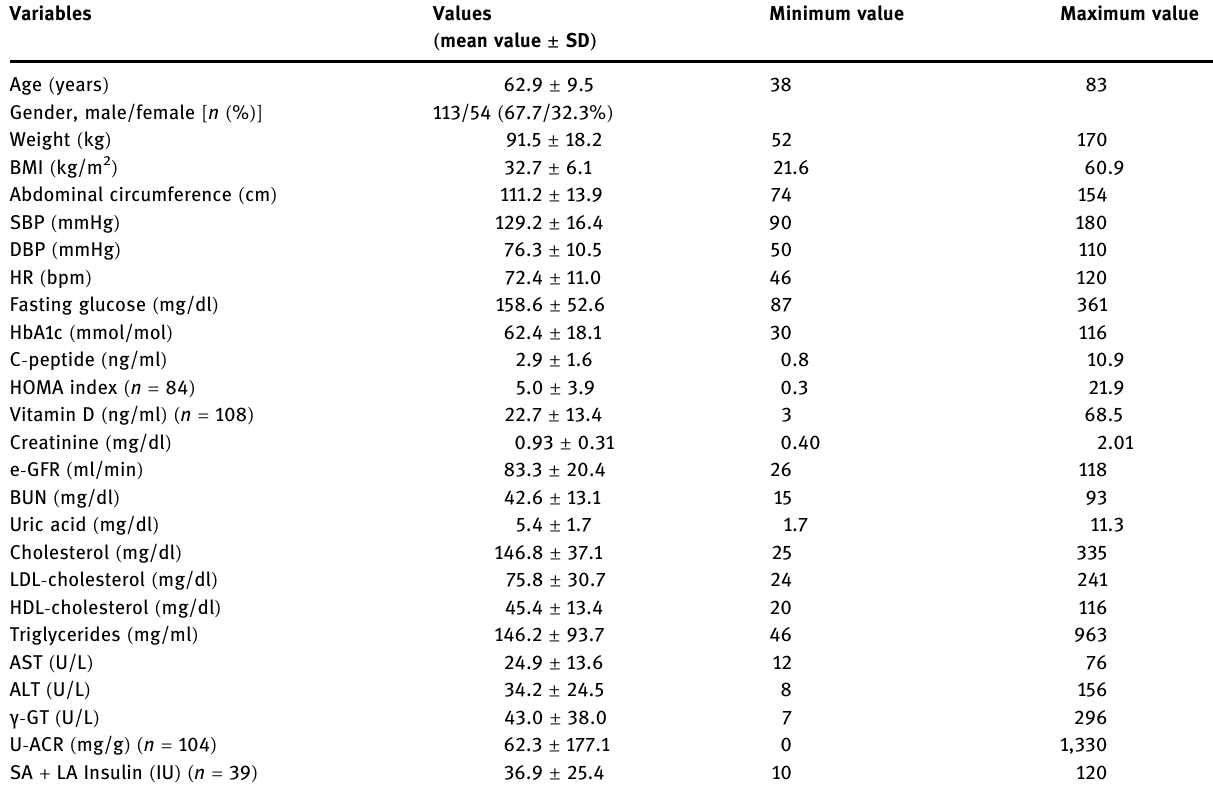
Table 1: Baseline characteristics of the total study population ( n = 167 )